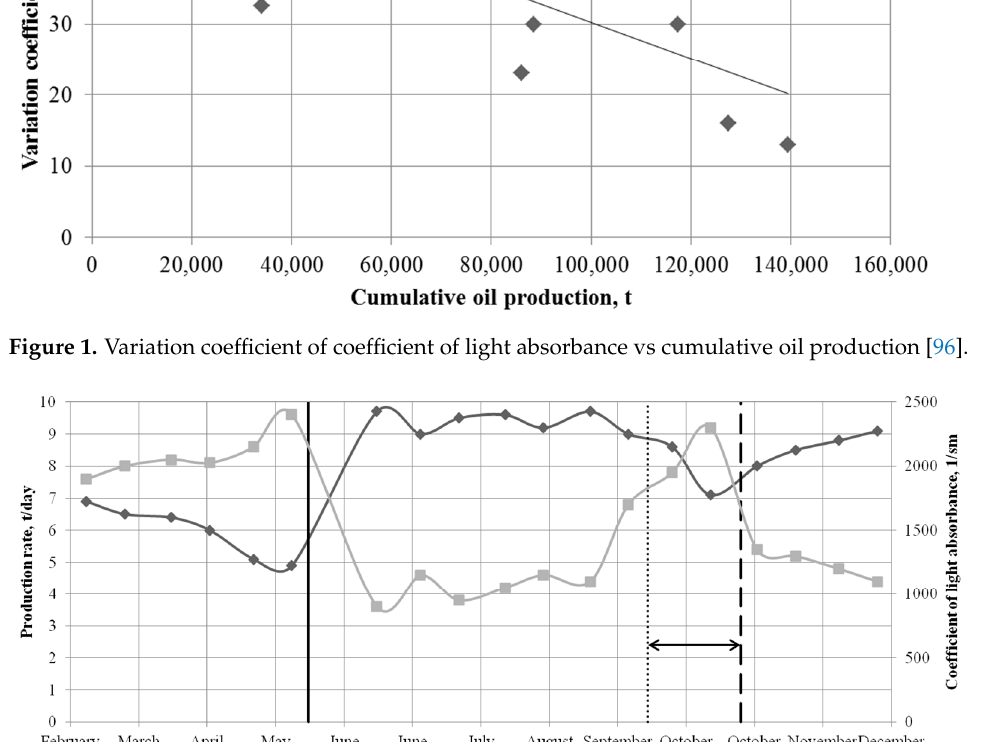
Figure 2. Oil production rate and coefficient of light absorbance variation before and after hydraulic fracturing [98].